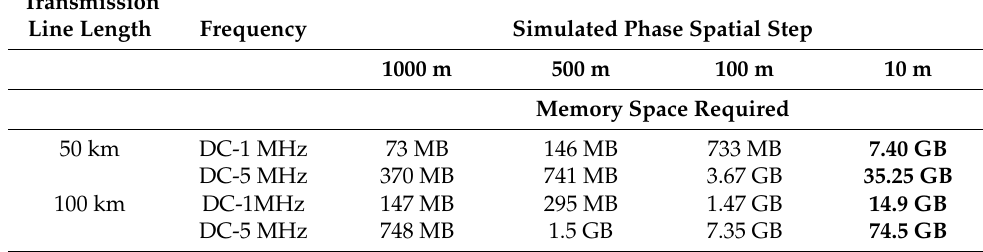
Table 5. Existing correlation estimator: memory space required for different spatial steps in the fault estimation